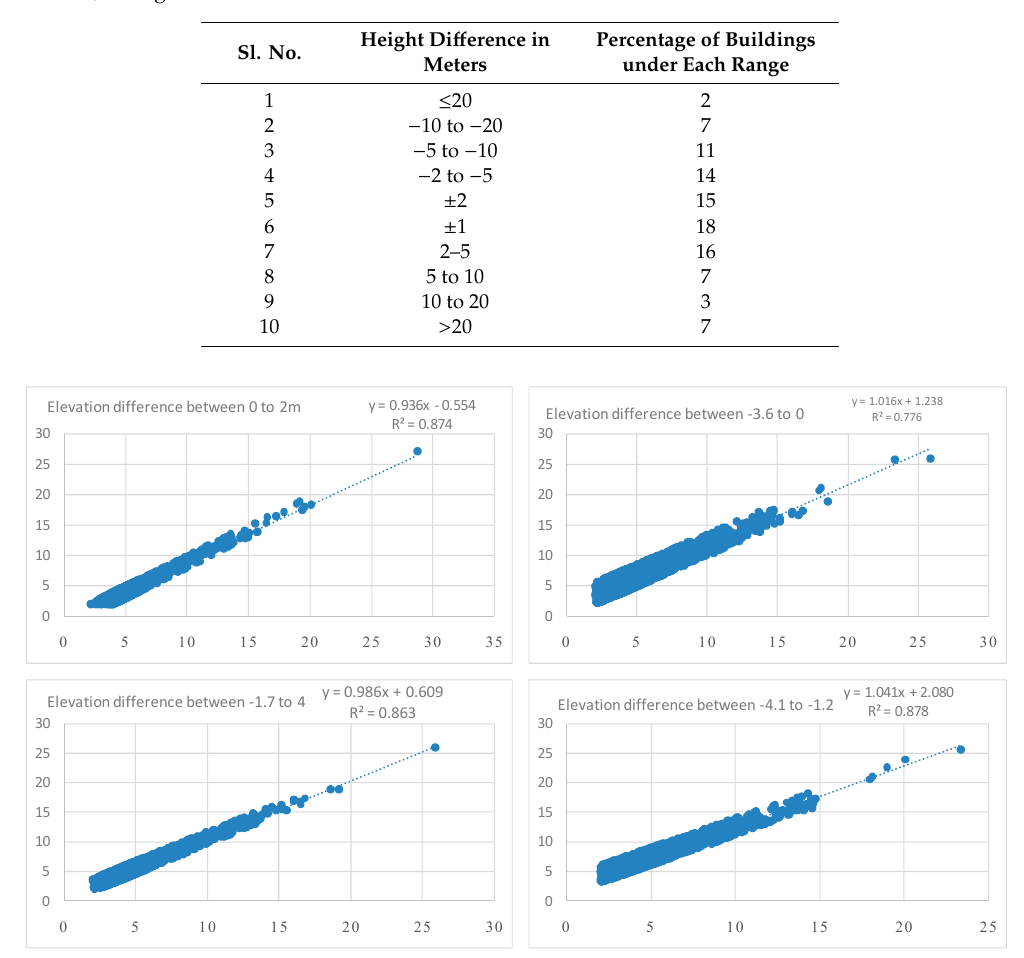
Figure A1. Percentage of buildings under each range for foundation 3D model in Nottingham. Table A1. Percentage of buildings under each error range for foundation 3D model in Huangpu District, Shanghai.